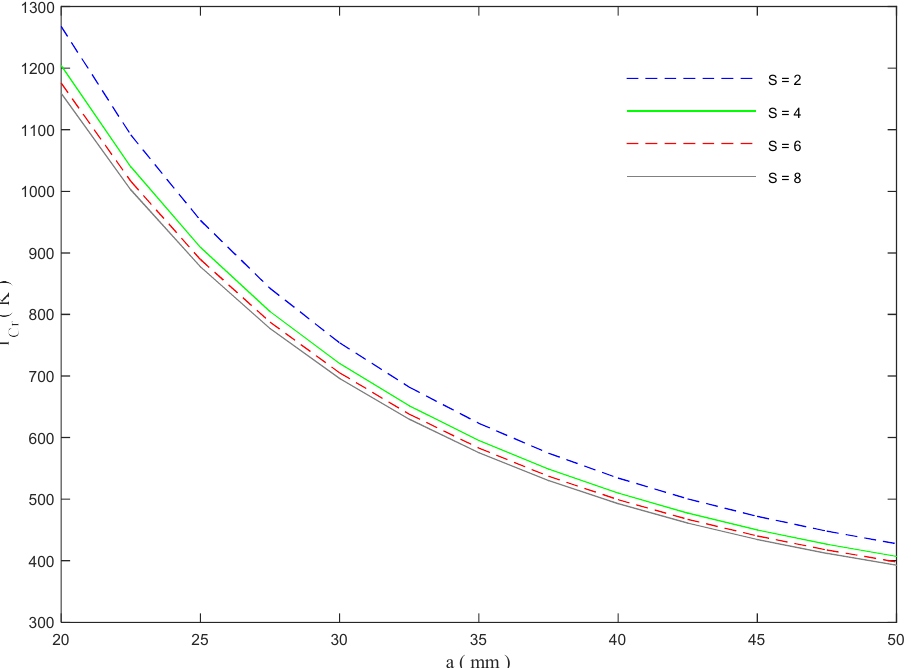
Figure 11. Critical buckling temperature versus the beam length, for different power-law indexes.